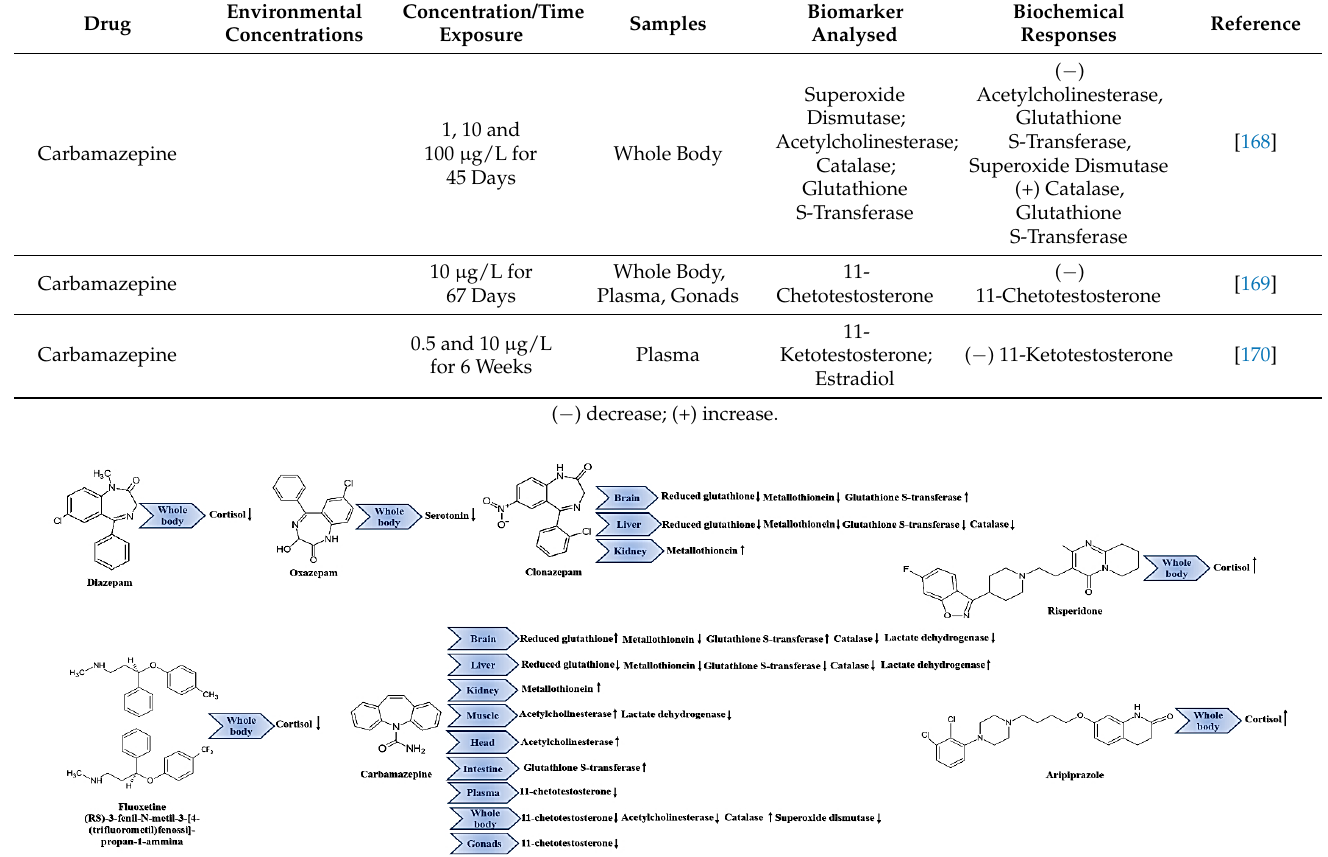
Figure 2. Schematic representation of the effects of antiepileptic and antipsychotic drugs on the biochemical responses of D. rerio adults. The arrow pointing up indicates “up-regulation” while the arrow pointing down indicates “down-regulation”.